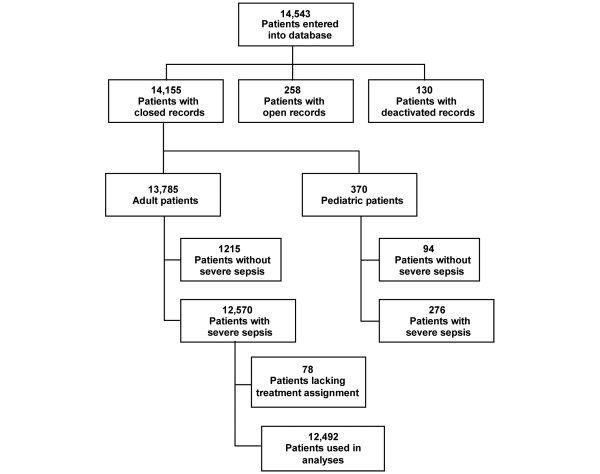
Patients were enrolled from December 2002 until December 2005 in 37 countries at 289 sites. There were 14,543 patients entered into the database of which 12,492 could be used for analyses.